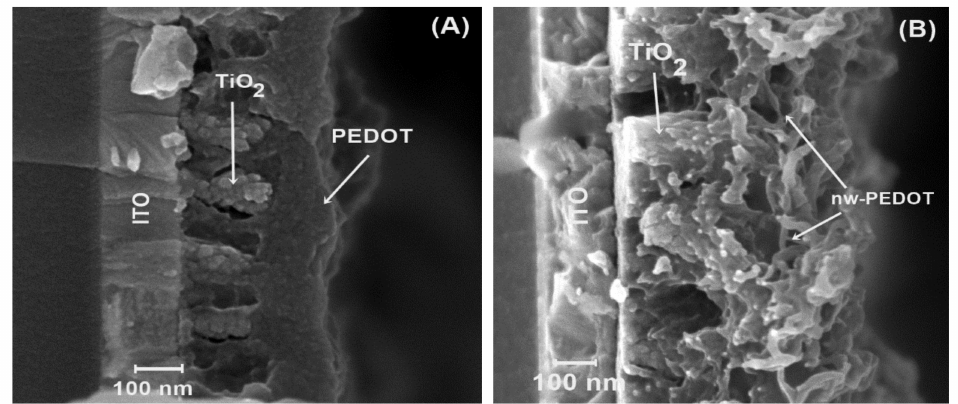
Figure 3. Electrodes’ morphological characterization. ( A ) ITO|TiO 2 |PEDOT and ( B ) ITO|TiO 2